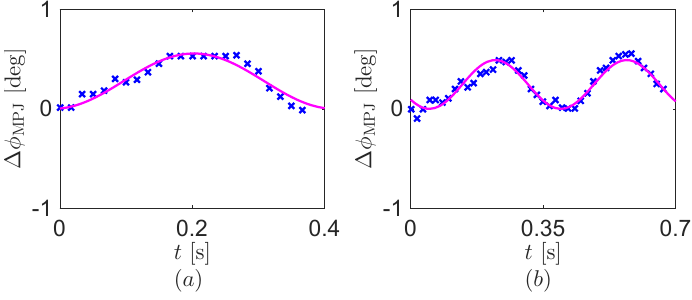
Figure 6. The angle φ MPJ of the human index finger. ( a ) One click and ( b ) double click. Blue crosses and purple lines are the experimental data and its fundamental harmonics, respectively.